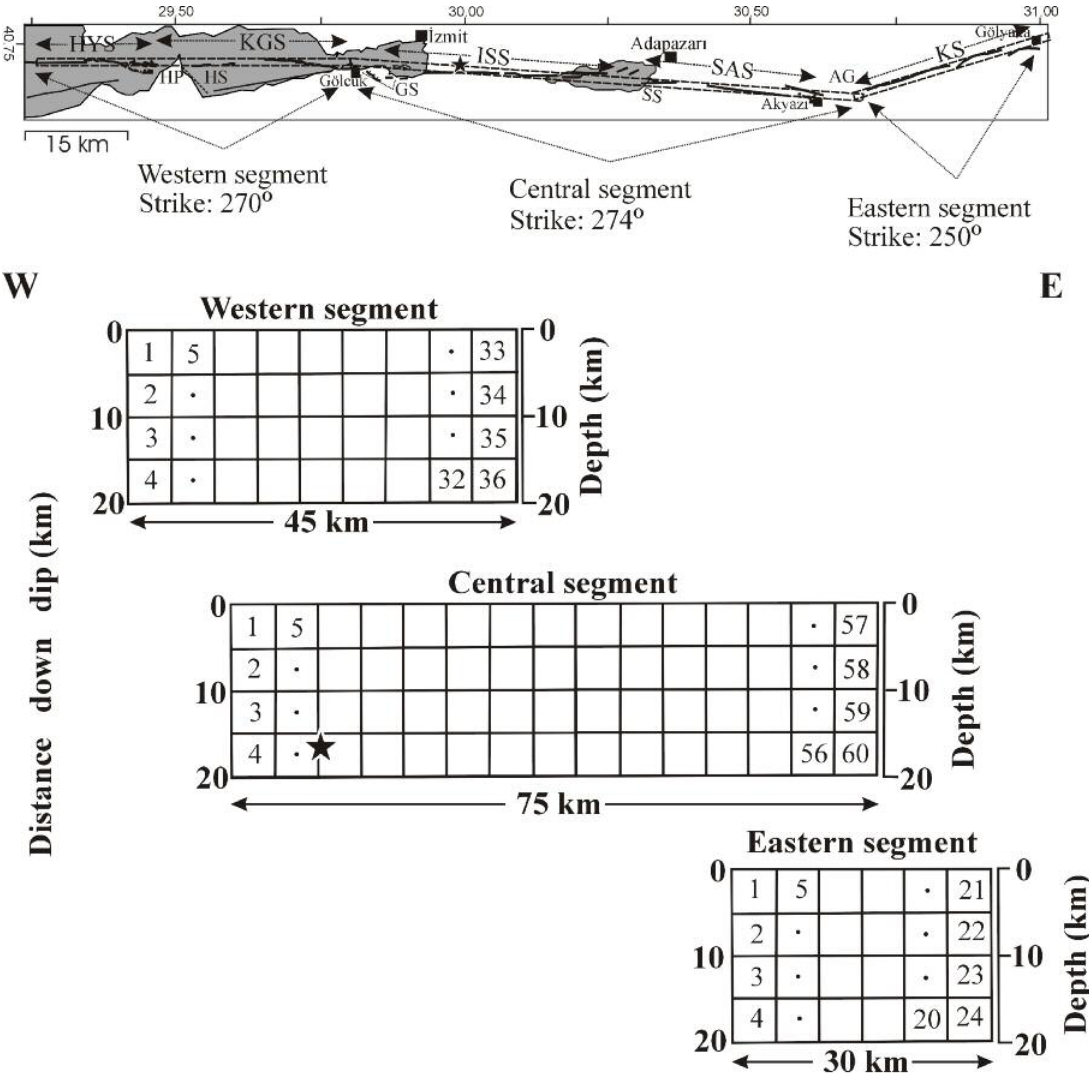
! Figure 5. Finite-fault model parameterization used to obtain the slip distribution of the 1999 İ zmit earthquake, along with the mapped surface ruptures. The three-segment model fault has a total length of 150 km, a width of 20 km, a dip 85˚N and is discretized as 120 square subfaults, with 5 km along each side. Solid stars, hypocenter; broken line rectangles in the map, surface projections of the model fault segments. The names and strikes of the fault segments adopted in the text and used in the modeling are also shown, respectively. See caption of Figure 3 for abbreviations used in the